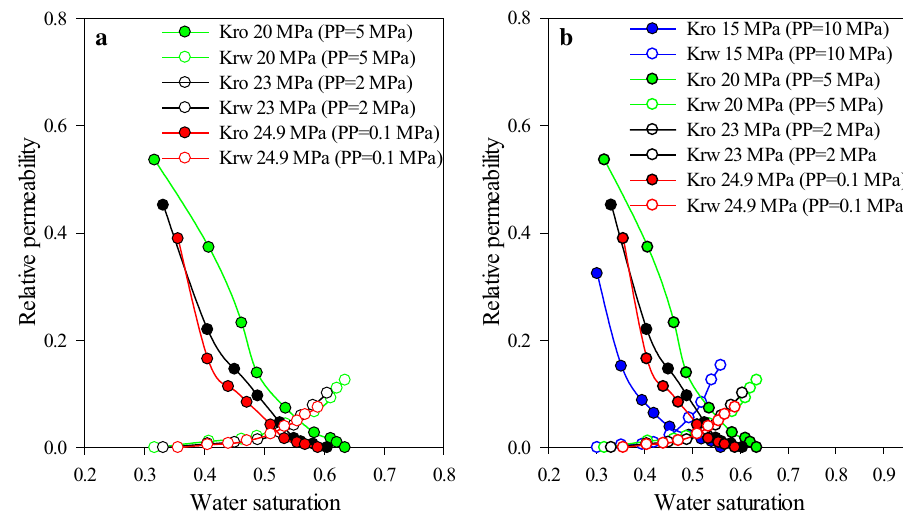
Fig. 9 Effect of pore pressure variation on water–oil rela- tive permeability: a low pore pressure range and b low-to- relatively high pore pressure variation